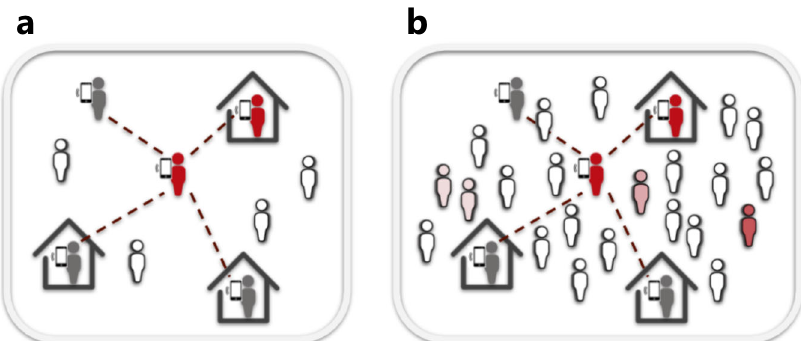
Fig. 1 Density and mobility in fl uence contact tracing app effectiveness. Compared to low density regions ( a ), epidemics may be signi fi cantly harder to contain through contact tracing apps in areas with very high population density ( b